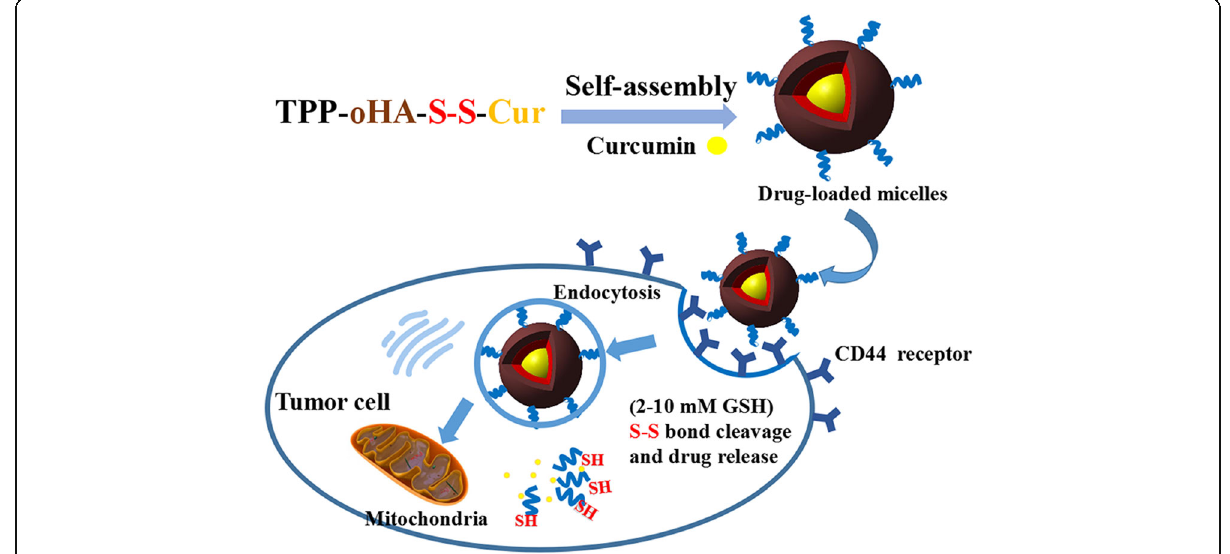
Fig. 1 Schematic illustration of mitochondrial and CD44 receptor dual-targeting redox-sensitive